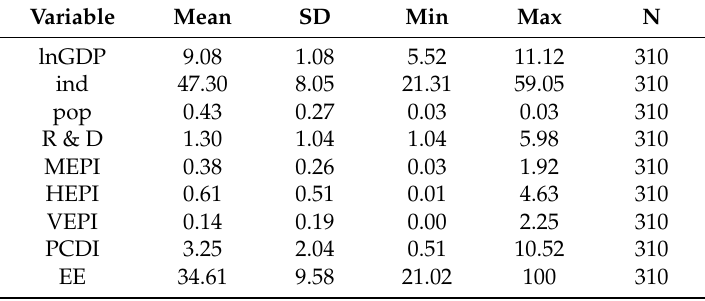
Table 4. The descriptive statistics of the variables in the regression